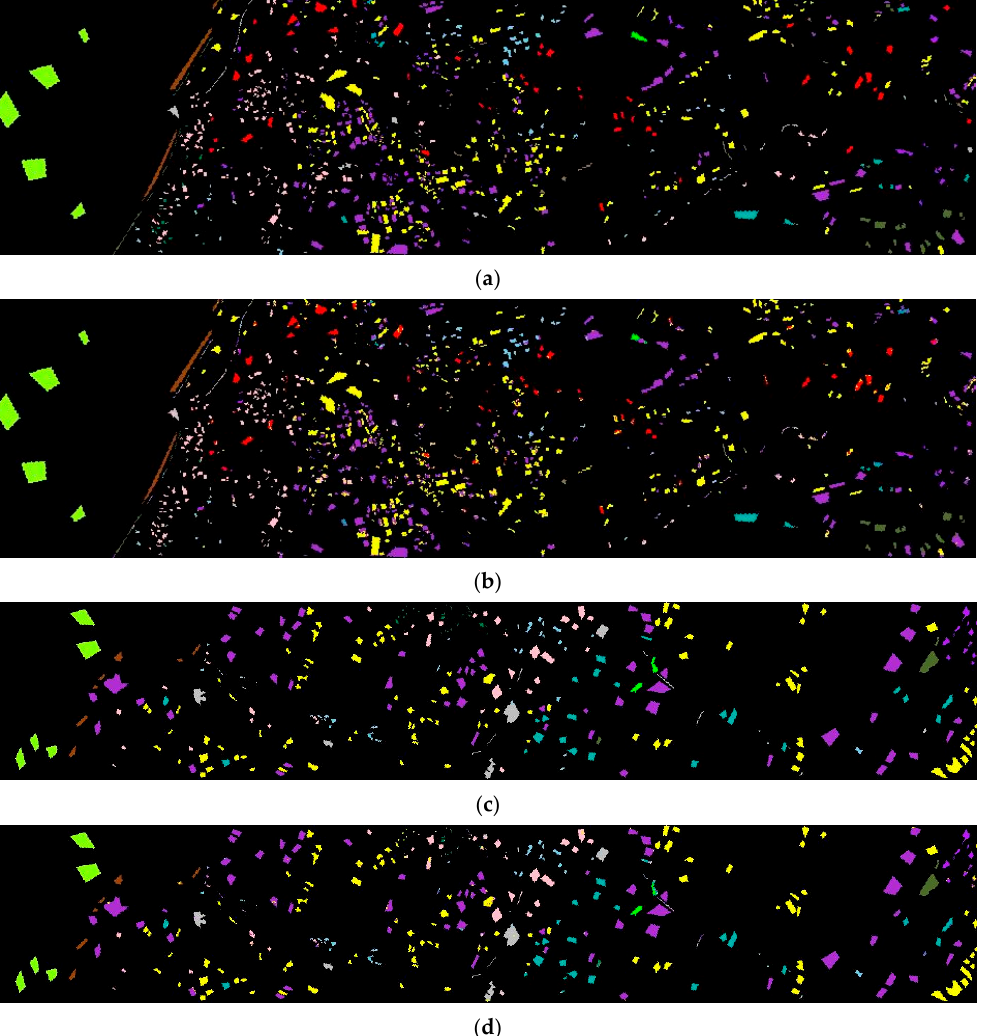
Figure 8. Feature maps produced using SVM classifiers and fusion features for the HyRANK dataset. ( a ) The ground truth